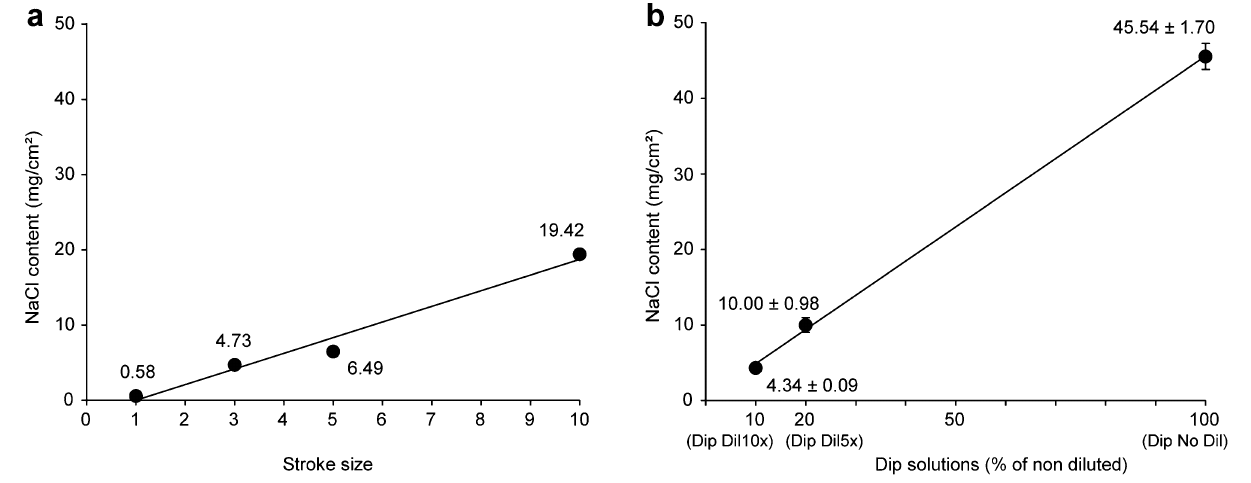
Figure 1. Concentrations of salt (sodium chloride, NaCl) deposited on spray- and dip-coated fabrics. For the Spr treatments, a single piece of material (42.25 cm 2 ) was prepared, and three pieces (1 cm 2 replicates) were cut out of it. For the Dip treatments, three samples (7.5 cm 2 ) were prepared separately. ( a ) Spray coating with stroke units 1, 3, 5, and 10. Regression line equation: Y = 2.0805x − 2.076; R 2 = 0.9774; R = 0.9886; P < 0.05. ( b ) Dip coating with a salt solution diluted 10 × , 5 × , or no dilution. Data are means ± standard deviations. Regression line equation: Y = 45.256x + 0.3492; R 2 = 0.9968; R = 0.9984; P < 0.0001. Weighed salt concentrations are displayed and expressed in milligrams per square